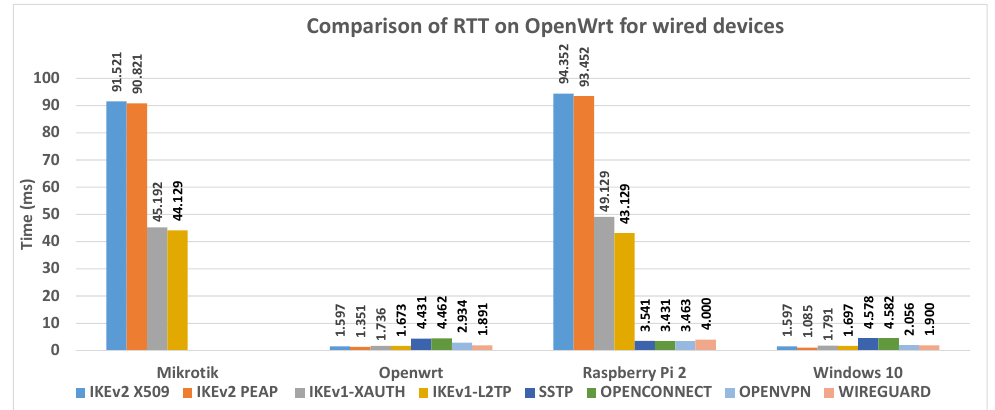
Figure 24. RTT data collected during the VPN connection tests with wired devices. In Figure 25 the RTT data collected during the VPN connection tests with wireless devices are shown. Both test batteries expected 200 packets sent from one endpoint to another.